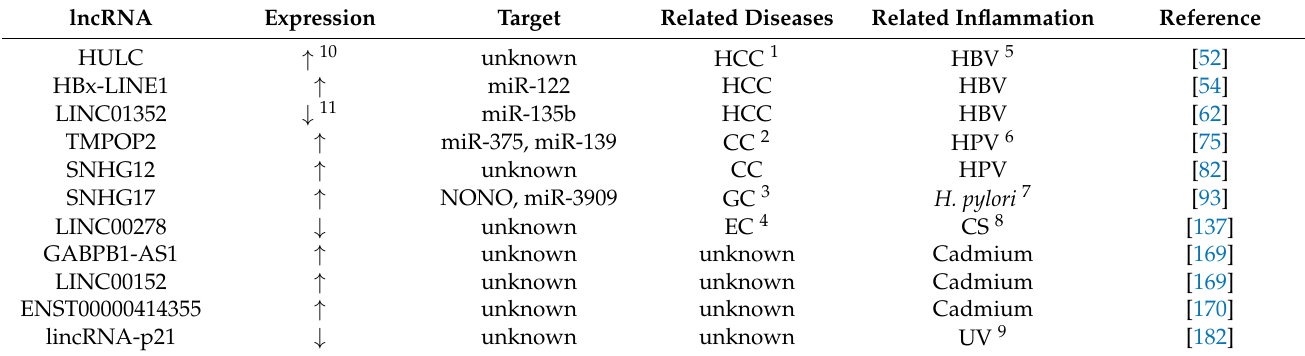
Table 2. Overview of lncRNAs in cancers regulated by